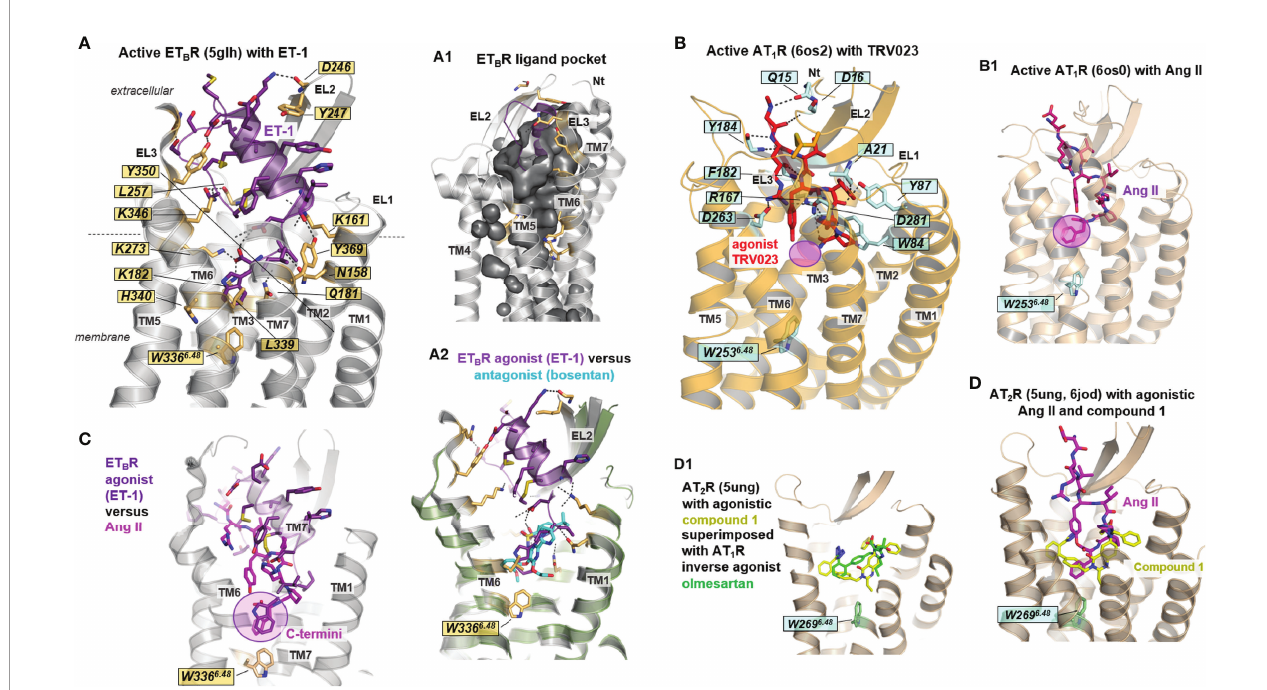
FIGURE 5 | Details of agonist binding at AT 1 R, AT 2 R, and ET B R. (A) The ligands ET and Ang (or their derivatives) are bound mainly between the N-terminus, EL2, and several transmembrane helices, whereby the ligand-binding cavity is embedded deeply toward the transmembrane helical core close to tryptophan W366 6.48 (ET B R). This essential tryptophan is in direct contact with the ligand-binding site of all receptors and their endogenous peptides [also (B, B1, C) ]. Of note, the arrestin-biased angiotensin II analog TRV023 does not contact the W 6.48 (B-B1) (magenta translucent circle). Many hydrophilic interactions between the receptors and the peptides can be observed, whereby four positively charged lysines and three tyrosines play a fundamental role in the corresponding ligand-receptor recognition in the ET B R/ET-1 complex. Generally, EL2, EL3, and the N-terminus cover the ligand-binding pocket [ (A1) , inner surface representation] extracellularly for both ET B R and ATRs. Several structures reveal direct interactions between the ligand and the N-terminus, for example, in the AT 1 R- b -arrestin biased agonist TRV026 (6os2) and ET B R- ET-3 (6igk) complexes. (A2) The bound peptide ET-1 in the ET B R (5glh) with superimposed non-peptidic antagonist bosentan (5xpr) shows partially overlapping binding pockets close to W 6.48 . (C) Superimposition of ET-1 (bound to ET B R, 5glh) and Ang II (bound to AT 1 R, 6os0) reveal structural differences between the ligands due to deviations in sequence composition and length (see also Figure 4A1 ); however, the C-terminally located aromatic residue in both ligands is close to the highly conserved W 6.48 , which is part of the activation-related toggle switch motif in helix 6. (D) Non-peptide AT 2 R agonists as compound 1 ( Table 1 ) are bound deep within the ligand-binding region. This section is also occupied by the endogenous peptide agonist Ang II, indicating a region highly relevant for receptor activation. (D1) The non-peptide inverse agonist olmesartan for AT 1 R (4zud) is principally bound in the same region as the AT 2 R non-peptide agonist compound 1 (5ung) with identical interactions to EL2. The different effects of these ligands are attributed to their detailed interactions in corresponding receptors (not visualized in